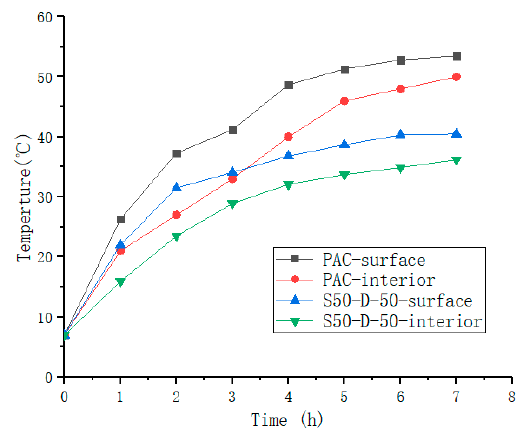
Figure 14. The surface and internal temperature in the first cycle.